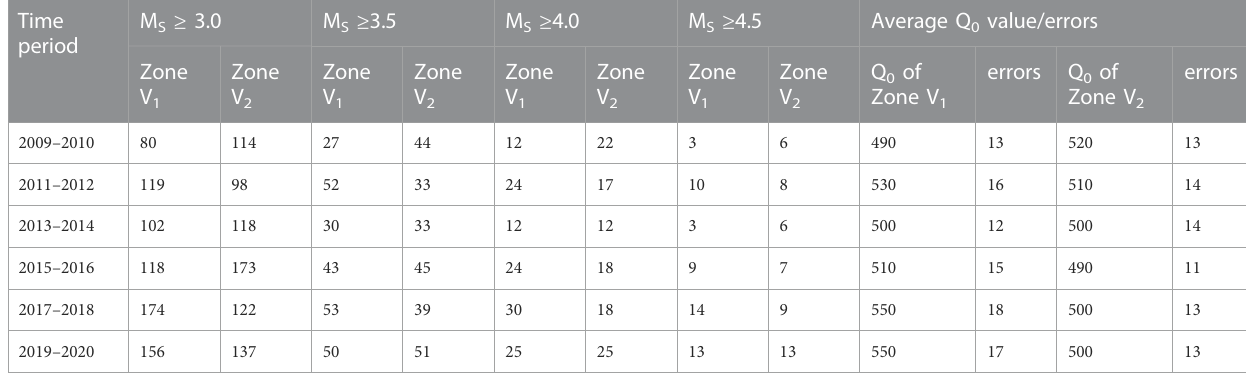
TABLE 2 Earthquake numbers and Q 0 values observed in the middle and southwestern regions of the Tianshan Mountains. Time